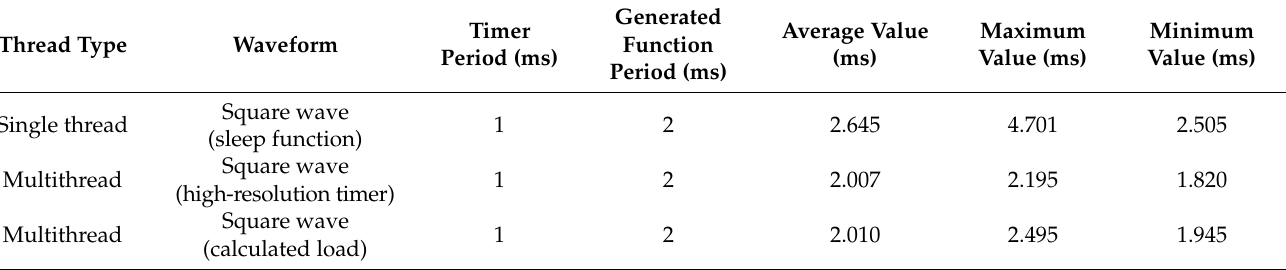
Table 1. Real-time test of the Windows